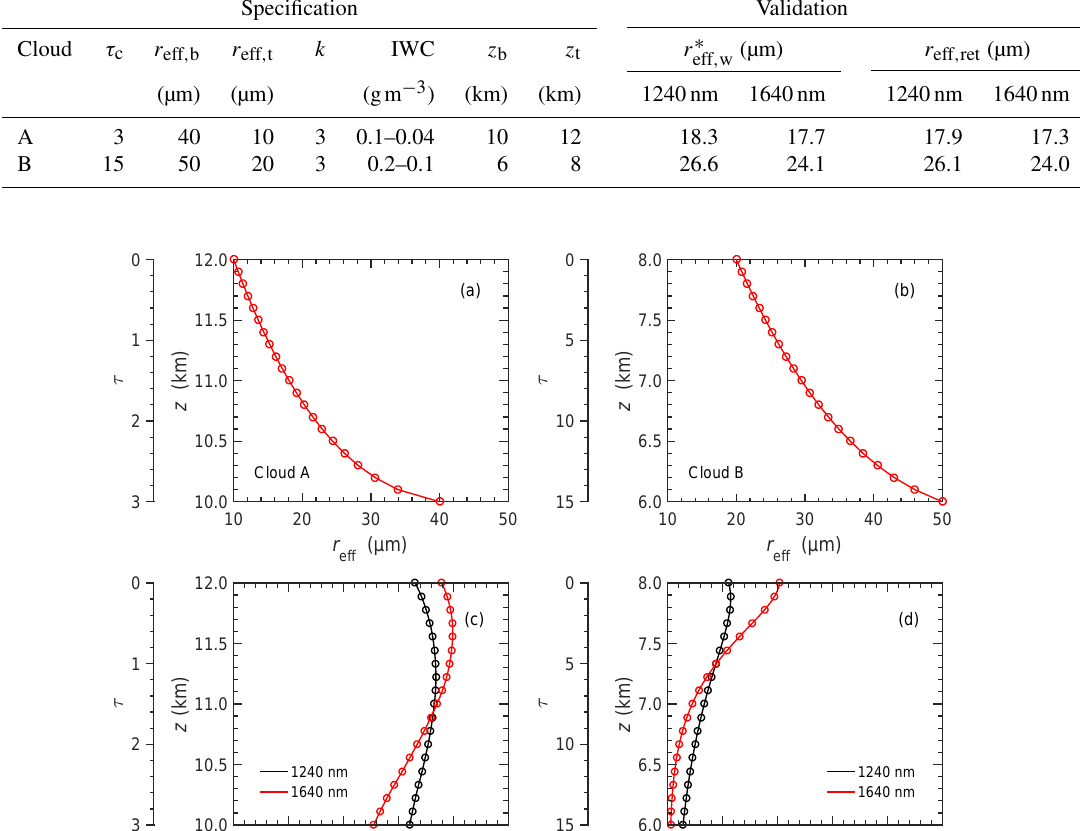
Table 3. Total optical thickness τ c , effective radius at the cloud top r eff , t and cloud base r eff , b , and IWC from the cloud base to the cloud top. z b and z t are the altitudes of the cloud base and cloud top, respectively. Retrieved r eff , ret is compared to the weighting estimate r ∗ near-infrared wavelengths at λ = 1240 and 1640nm.